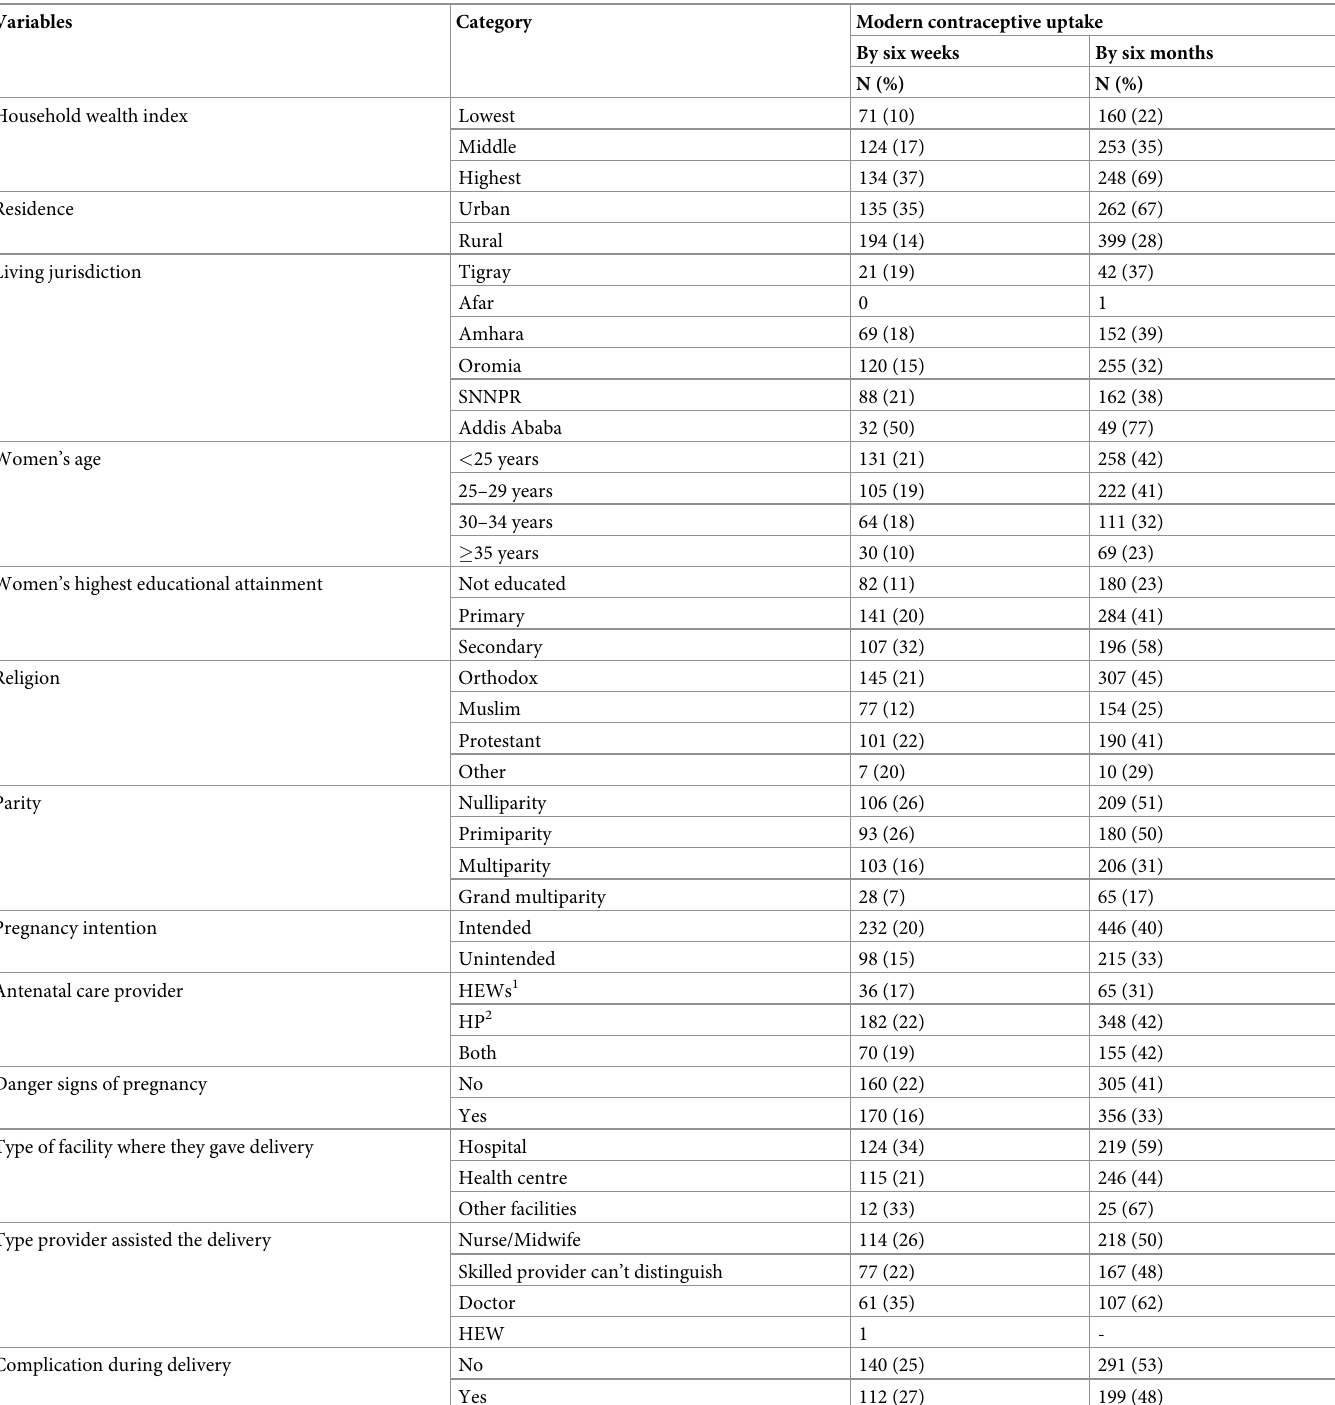
Table 2. Characteristics of study participants by modern contraceptive uptake by six weeks and six months